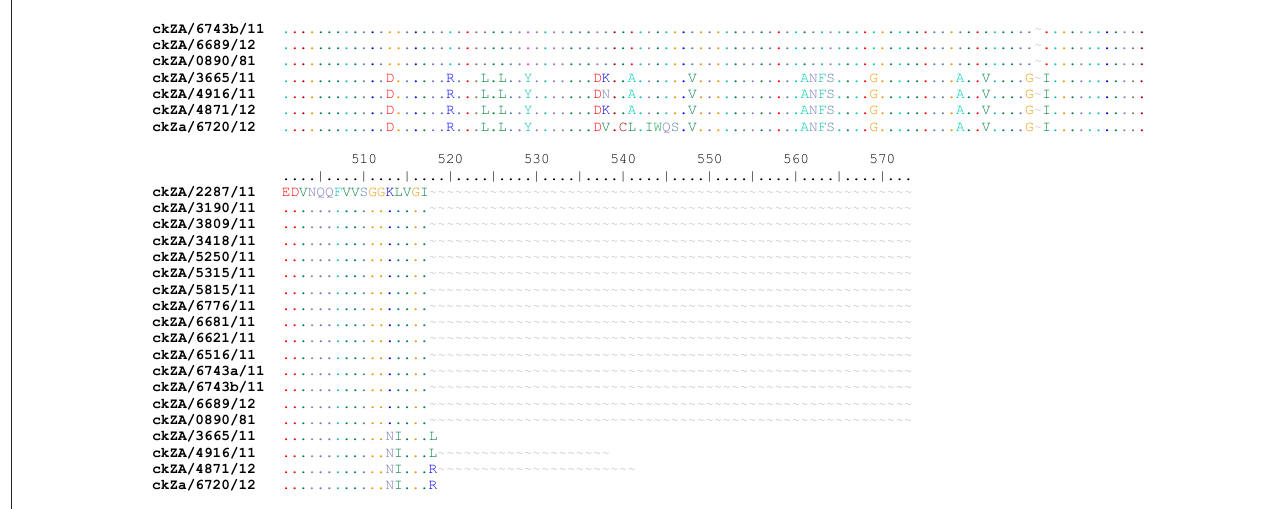
FIGURE 2 FIGURE 2 (Continues...): Multiple amino acid sequence alignment for full S1 proteins. Hypervariable regions are indicated in grey. The first sequence is used as a reference and identities are plotted as